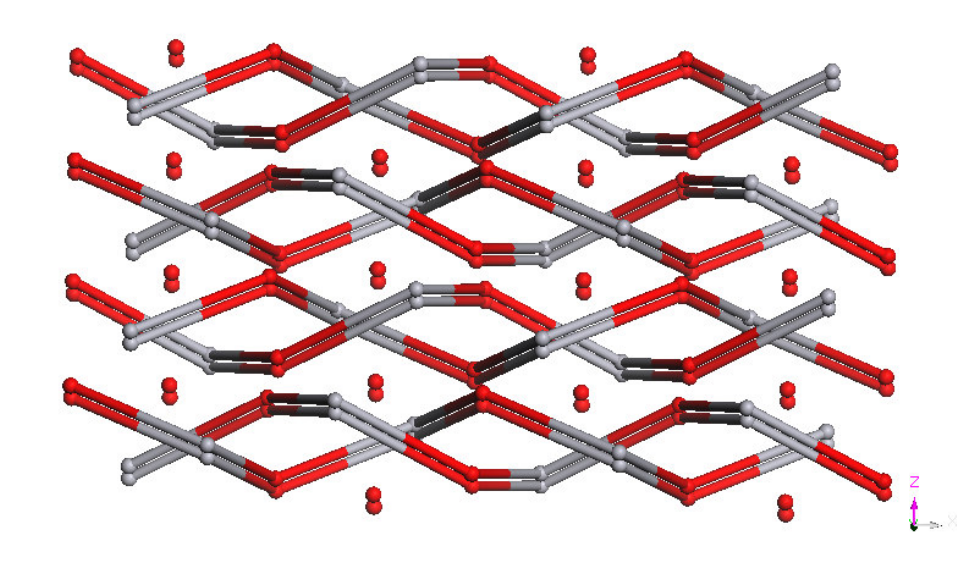
Figure 3. Schematic representation of double stranded helices in 1 along [001]. Red balls represent O atoms and grey balls represent Hg